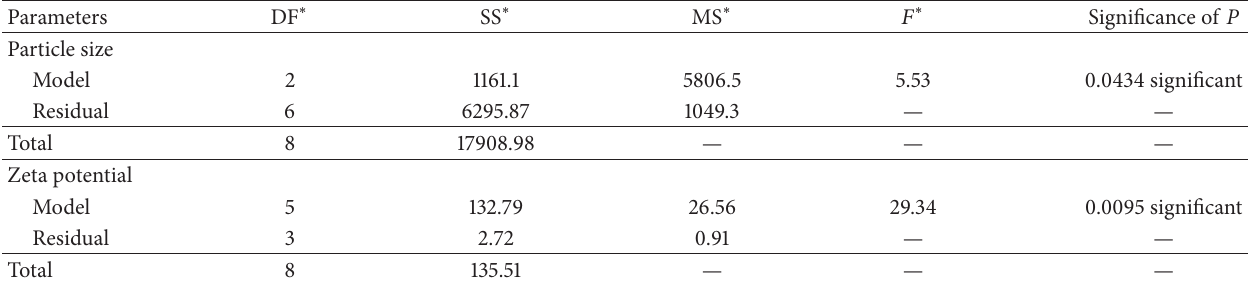
Table 3: Results of analysis of variance for particle size.